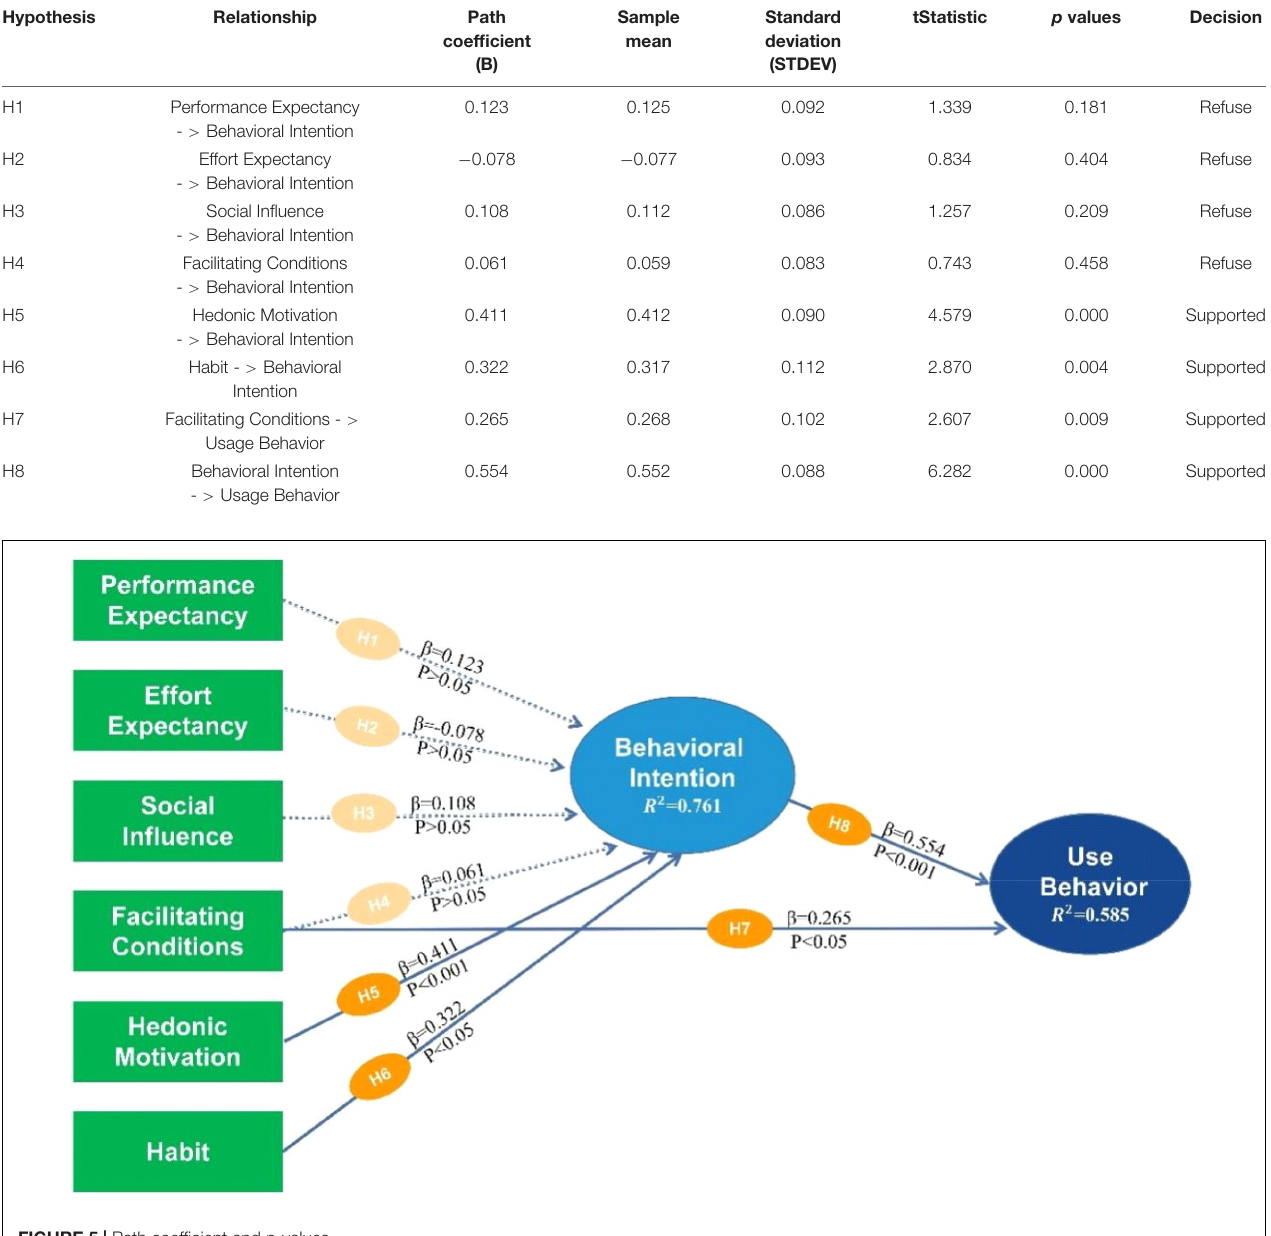
TABLE 7 | Hypothesis analysis.